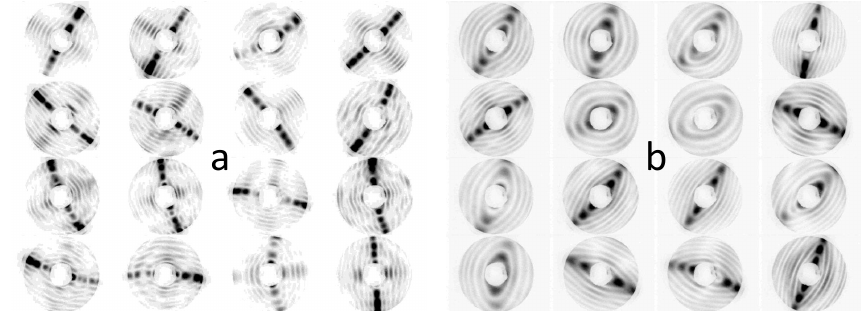
Fig. 12. Representative selection of SID3 single particle scattering patterns recorded in HALO06 25 during a growth period (a) and a subli- mation period (b) . A statistical analysis of the images revealed that more than 60% of the ice particles had a columnar shape with a two-fold or four-fold symmetric pattern. The sublimation of ice particles results in roundish particle shapes inducing oval scattering patterns (b)